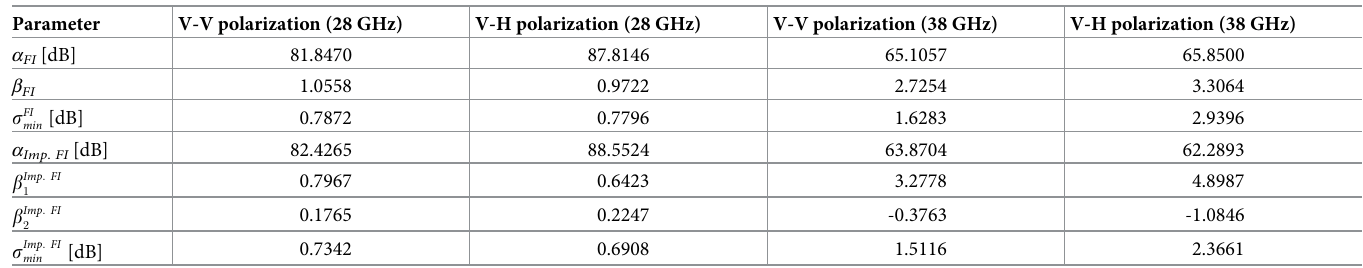
Table 5. Parameters for the standard FI and improved FI models for the NLOS SCE.